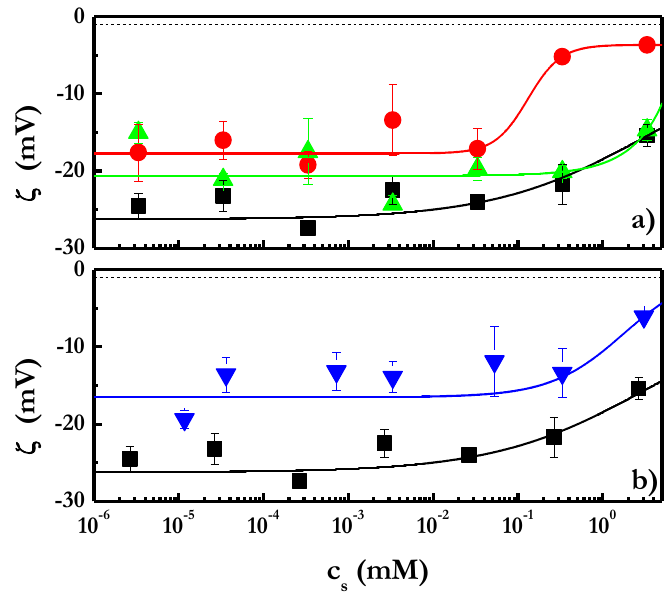
Figure 3. Dependence of the ζ potential on the surfactant concentration, c s , for the different polymer + surfactant mixtures studied in this work: ( a ) ζ values for pseudo-binary and pseudo-ternary mixtures of DSPE-PEG containing SLES and/or CB. ( ■ ) SLES, (●) CB and ( ▲ ) SLES+CB (molar ratio 3:2); ( b ) ζ values for pseudo-binary of DSPE-PEG containing SLES or SLMI. ( ■ ) SLES and ( ▼ ) SLMI. All the mixtures contain a fixed DSPE-PEG concentration of 5 g/L, and their ionic strength and pH were fixed a 40 mM (KCl) and 5.6, respectively. The dashed line corresponds to the value of ζ for a DSPE-PEG aqueous solution with concentration 5 g/L and the same ionic strength and pH than the mixtures.